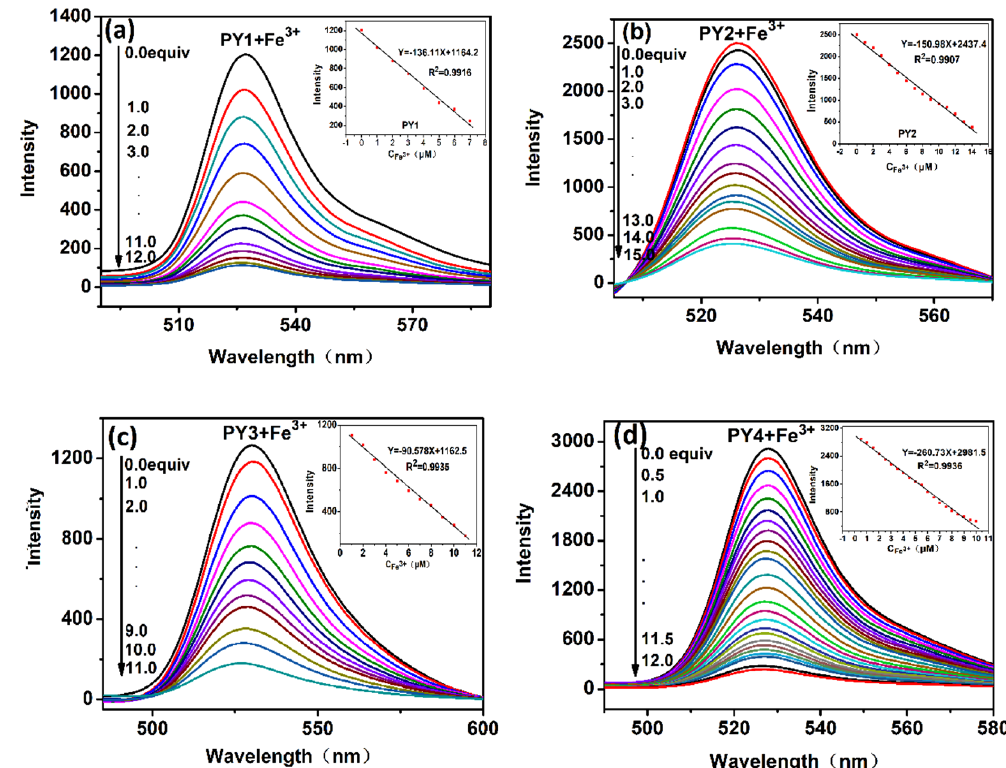
Fig. 5 BODIPY-based polymers response to Fe 3+ concentration. a PY1, b PY2, c PY3, and d PY4